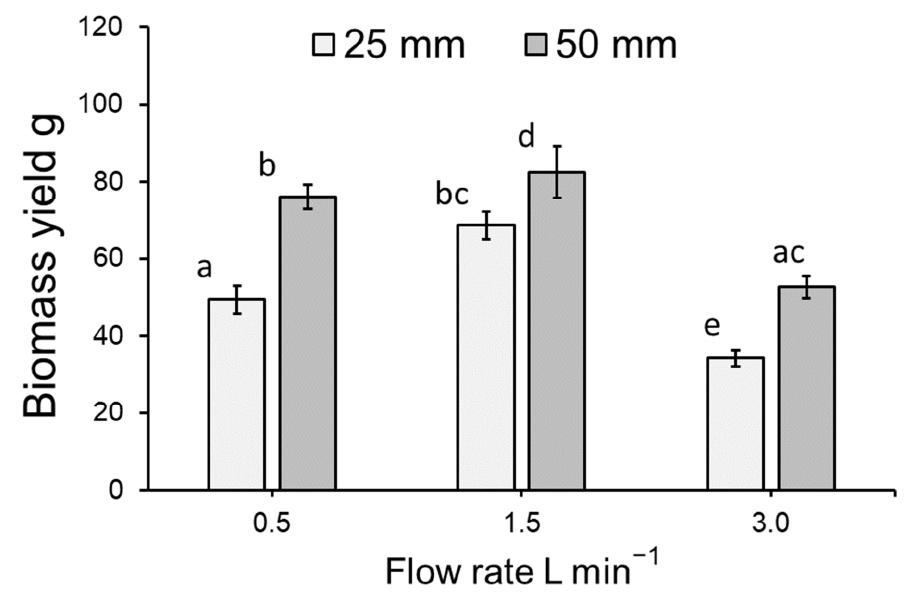
Figure 3. Mean ( ± SE) biomass yield (g) for Lemna minor grown within an indoor, vertically stacked system. As no effect of tray position was detected, trays have been pooled in this simplified model depiction. Letters show statistical similarity ( p > 0.05). See Figure 2 for full model depiction. Biomass yields were used to calculate RGR values to facilitate comparison with pub- lished literature. The RGR significantly differed for L. minor subjected to different treat- ments within the stacked system (ANOVA: χ 2 = 108.98, df = 6; p < 0.0001: Figure 4A,B). Flow rate, medium depth, and assessment period (i.e., day 0–3 and day 3–7) had a signif- icant effect on biomass yield (all p < 0.0001). RGR was generally greater for plants grown on a medium depth of 50 mm rather than 25 mm ( p < 0.0001; Figure 4A,B). While RGR tended to be slightly lower for plants grown on a flow rate of 3.0 L min − 1 , this was not always statistically apparent (Figure 4A,B). A significant interaction effect on RGR was detected for flow and assessment period ( p < 0.001). Furthermore, although not always statistically apparent, the RGR tended to be greater for plants grown in the period of days 0–3 compared to day 3–7 (Figure 4A,B).